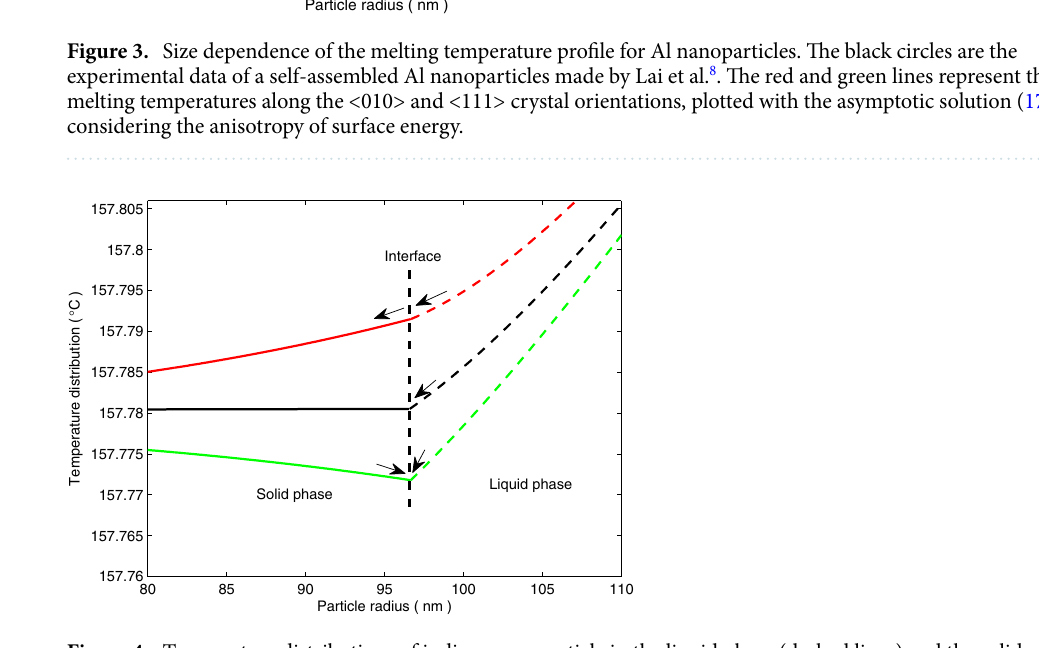
flux flows out from the solid phase into the interface. This behavior reduces the equilibrium temperature at the interface and then reduces the melting temperature. Along the <010> crystal orientations, there exist the tem- ∂ r ( R , t ) > 0 near the interface, signifying that the heat flux flows into the interface from the liquid phase and then flows into the solid phase from the interface (arrows on red lines in Fig. 4). Along the <010> crystal orientations, in addition to the heat flux required for melting, the surplus of heat flux then flows from the interface into the solid phase. While heat flux is flowing into the solid phase from the interface, the melting temperature increases with the increasing equilibrium temperature at the interface. When the anisotropy of surface energy is neglected (black line in Fig. 4), there feature the temperature gradients ∂ T L ∂ r ( R , t ) > 0 and ∂ T S ∂ r ( R , t ) = 0 near the interface, signifying that there is no heat flux from the interface into the solid phase. This explains that compared with the isotropic surface energy, the anisotropy of surface (cid:31) (cid:31) energy enhances the melting temperature of micro/nanoparticles along the <010> crystal orientations, whereas depresses the melting temperature of micro/nanoparticles along the <111> crystal orientations. The differences in the temperature gradients of two phases near the interface affected by the anisotropy of surface energy results in the differences in the heat flux direction during the melting process, which explains the dependence of melting temperature on crystal orientations observed in the experiment of Zhang and Cantor 6 . ∂ t on the particle radius R under Figure 5a illustrates the dimensionless dependence of the interface speed ∂ R various surface energy values using the asymptotic solution (18). The negative interface speed indicates the direc- (cid:31) tion of the particle radius moving towards the particle center. When the isotropic surface energy is considered, the interface speed monotonically increases with decreasing particle radius. When the isotropic surface energy